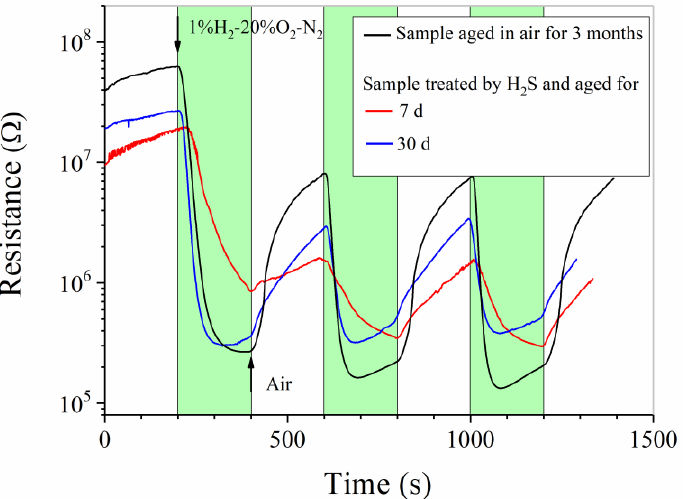
Figure 6. Room-temperature responses to 1% H 2 –20% O 2 –N 2 and recoveries in air for two Pt–SnO 2 composite nanoceramic samples: one had been aged in air for three months, and the other one had been exposed to H 2 S at room temperature and then aged in air for 7 d and 30 d separately.